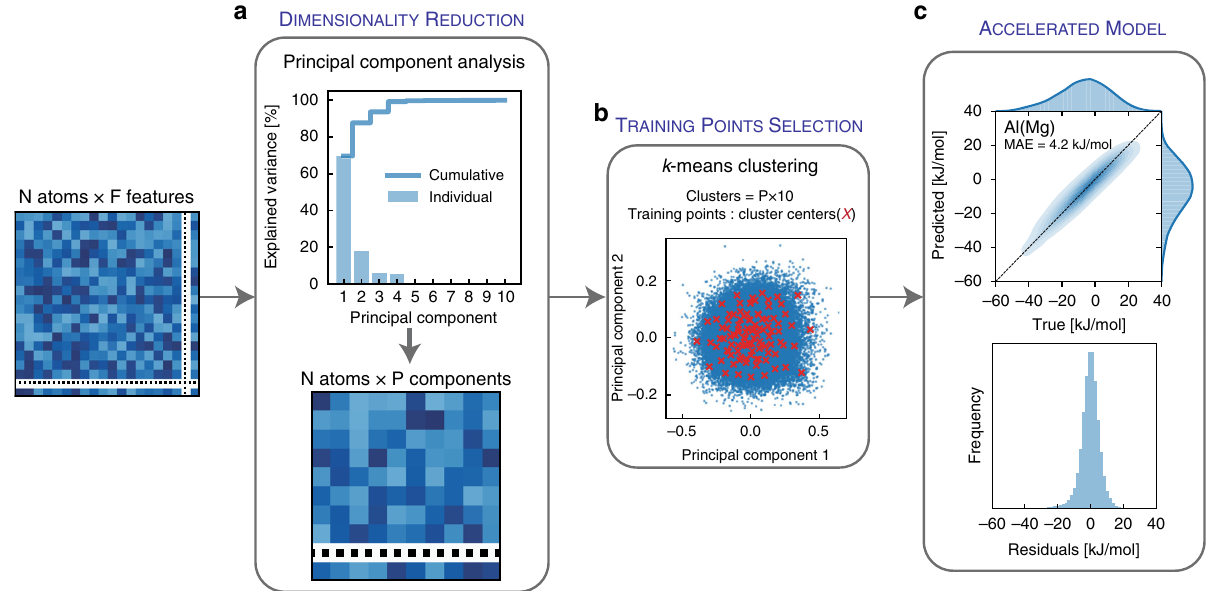
Fig. 3 Accelerated ML model for GB segregation. For the Al(Mg) alloy, shown in Fig. 1, ( a ) principal component analysis is used to reduce the dimensionality of the feature matrix by projecting the F SOAP features into P = 10 components that capture >99% of the variance. b k -means clustering is then used to divide the 10-d transformed feature space into P × 10 = 100 similar clusters; the closest GB sites to the cluster centers (shortest Euclidean distance) are used as training data-points for the learning algorithm (linear regression). c Predictive performance — mean absolute error (MAE) — of the accelerated model across the full Al GB network.